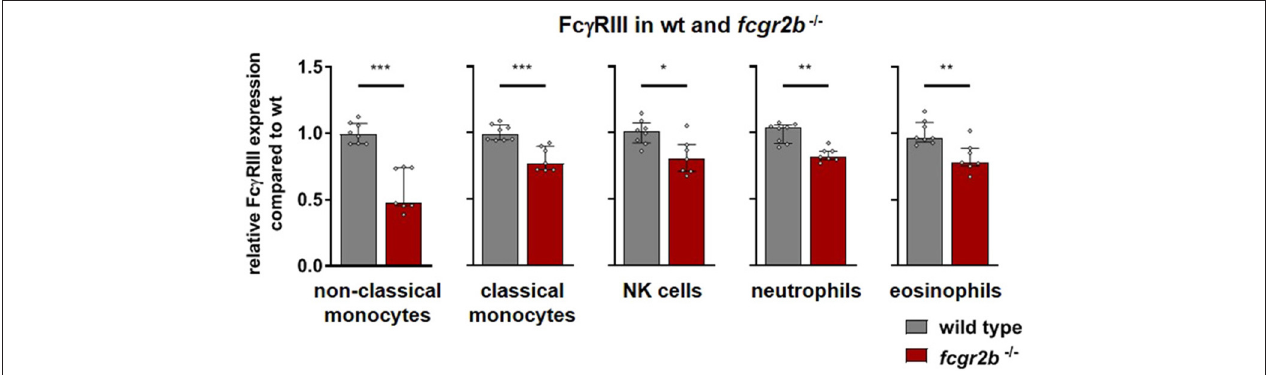
FIGURE 3 | Activating Fc gamma receptors on PBLs of wild type and inhibitory Fc γ R knockout mice. Depicted are the anti-Fc γ RIII binding sites per cell for wild type (gray bars) and fcgr2b − / − knockout mice (red bars) from two experiments, normalized to the mean expression in the respective wild type cohort. n = 7–8; Shown is the median ± IR together with the individual values; Mann-Whitney test for significance; * p < 0.05; ** p < 0.01; *** p <